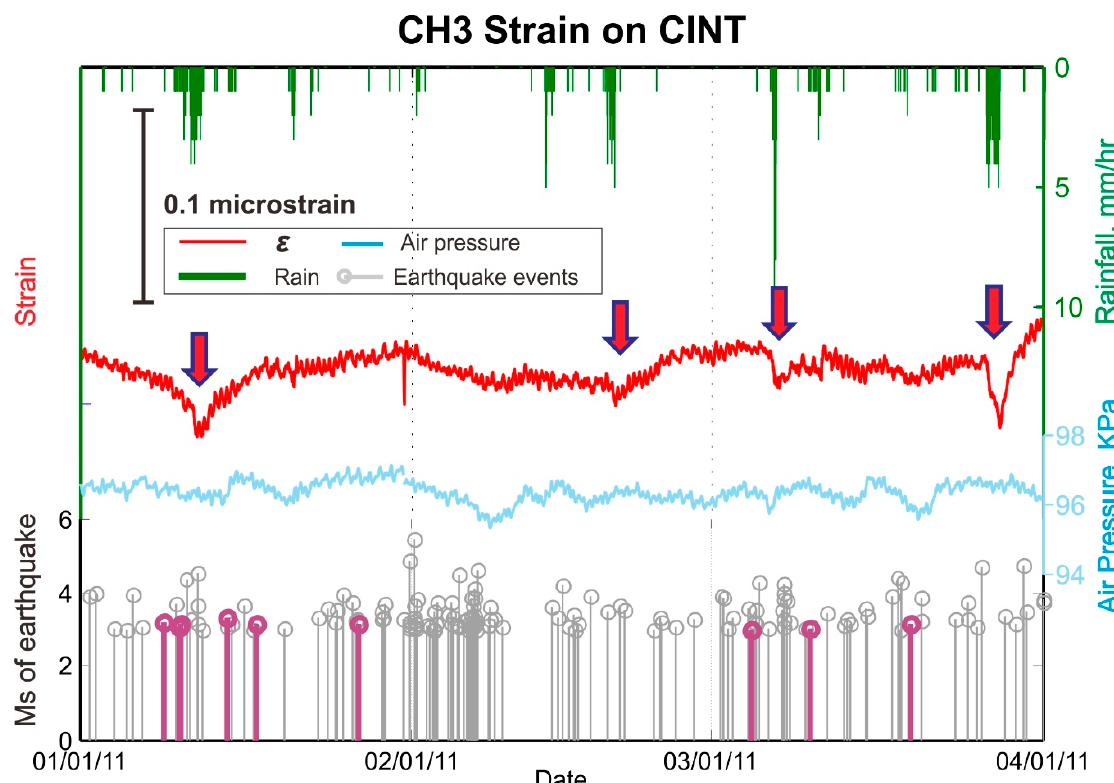
Figure 2. Responses of air pressure and rainfall observed on channel 3 (CH3) at station CINT. Light blue lines represent air pressure records; green lines are hourly rainfall; the light gray and purple bars indicate seismic events within 100 km and 50 km from CINT, respectively. ε is the residual strain removing atmosphere and tidal response, separately. After removing the response of air pressure and tides, the influence of rainfall becomes apparent (pointed by red arrows).